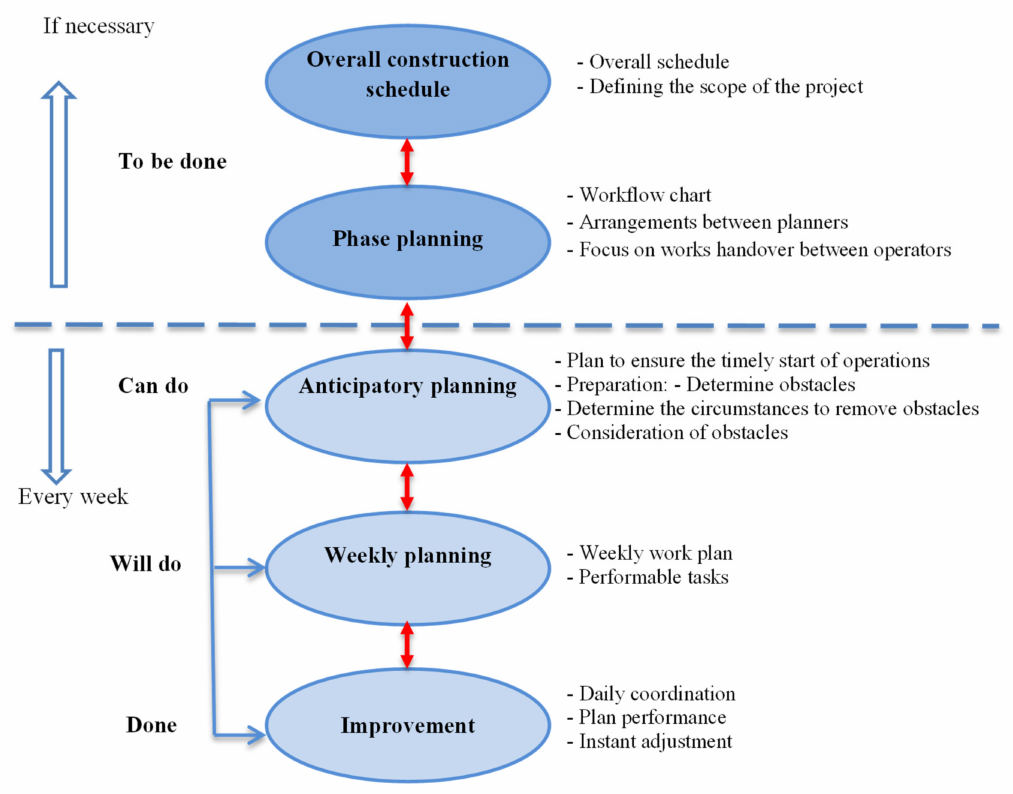
Figure 1. Last planner